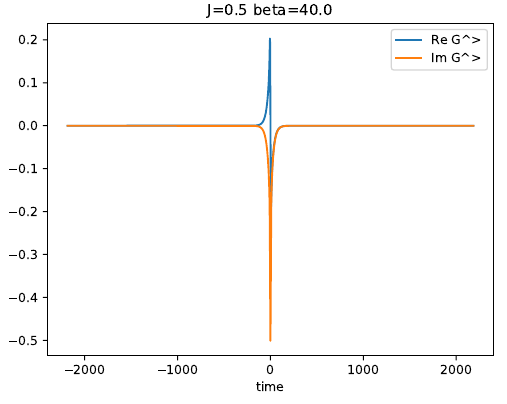
Figure 12 . Wightman function G > for single q = 4 SYK with J = 0 . 5 , β = 40